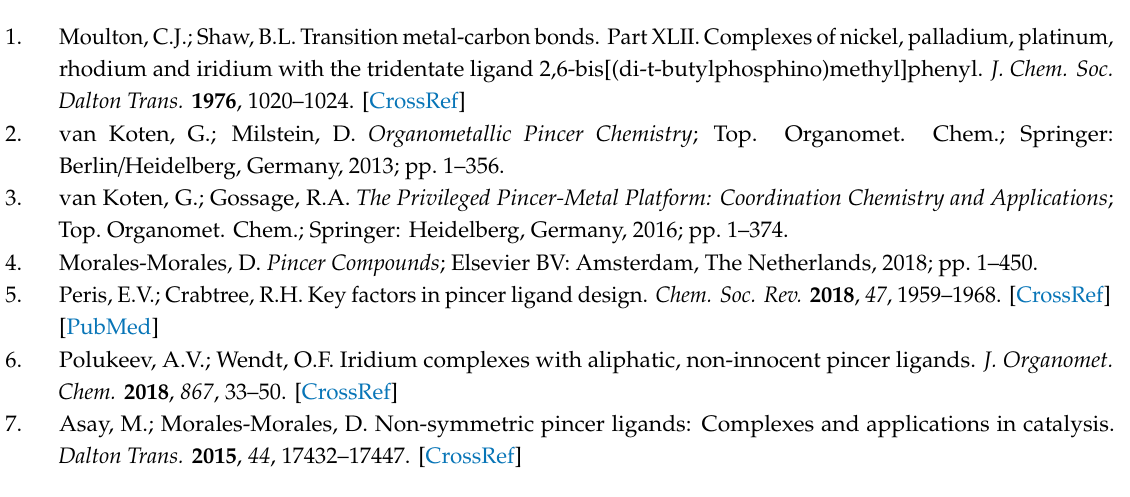
parameters for 3a , 3b . Figure S1: 1 H NMR spectrum (400.13 MHz) of 2a in CDCl 3 . Figure S2: 31 P{ 1 H} NMR spectrum (161.98 MHz) of 2a in CDCl 3 . Figure S3: 19 F NMR spectrum (376.50 MHz) of 2a in CDCl 3 . Figure S4: 13 C{ 1 H} NMR spectrum (150.93 MHz) of 2a in CDCl 1 H NMR spectrum (400.13 MHz) of 3a in C 3 . Figure S5: 6 D 6 . Figure S6: 11 B{ 1 H} NMR spectrum (128.38 MHz) of 3a in C 6 D 6 . Figure S7: 31 P{ 1 H} NMR spectrum (121.49 MHz) of 3a in C 6 D 6 . Figure S8: 19 F NMR spectrum (376.50 MHz) of 3a in C 6 D 6 . Figure S9: 13 C{ 1 H} NMR spectrum (150.93 MHz) of 3a in C 6 D 6 . Figure S10: 1 H NMR spectrum (400.13 MHz) of 3b in C 6 D 6 . Figure S11: 11 B{ 1 H} NMR spectrum (128.38 MHz) of 3b in C 6 D 6 . Figure S12: 31 P{ 1 H} NMR spectrum (161.98 MHz) of 3b in C 6 D 6 . Figure S13: 13 C{ 1 H} NMR spectrum (150.93 MHz) of 3b in C 6 D 6 . Figure S14: FTIR spectra of 3a in KBr pellet. Figure S15: FTIR spectra of 3b in KBr pellet. Figure S16: FTIR spectra of 3a in the CH 2 Cl 2 solution. Figure S17: FTIR spectra of 3b in the CH 2 Cl 2